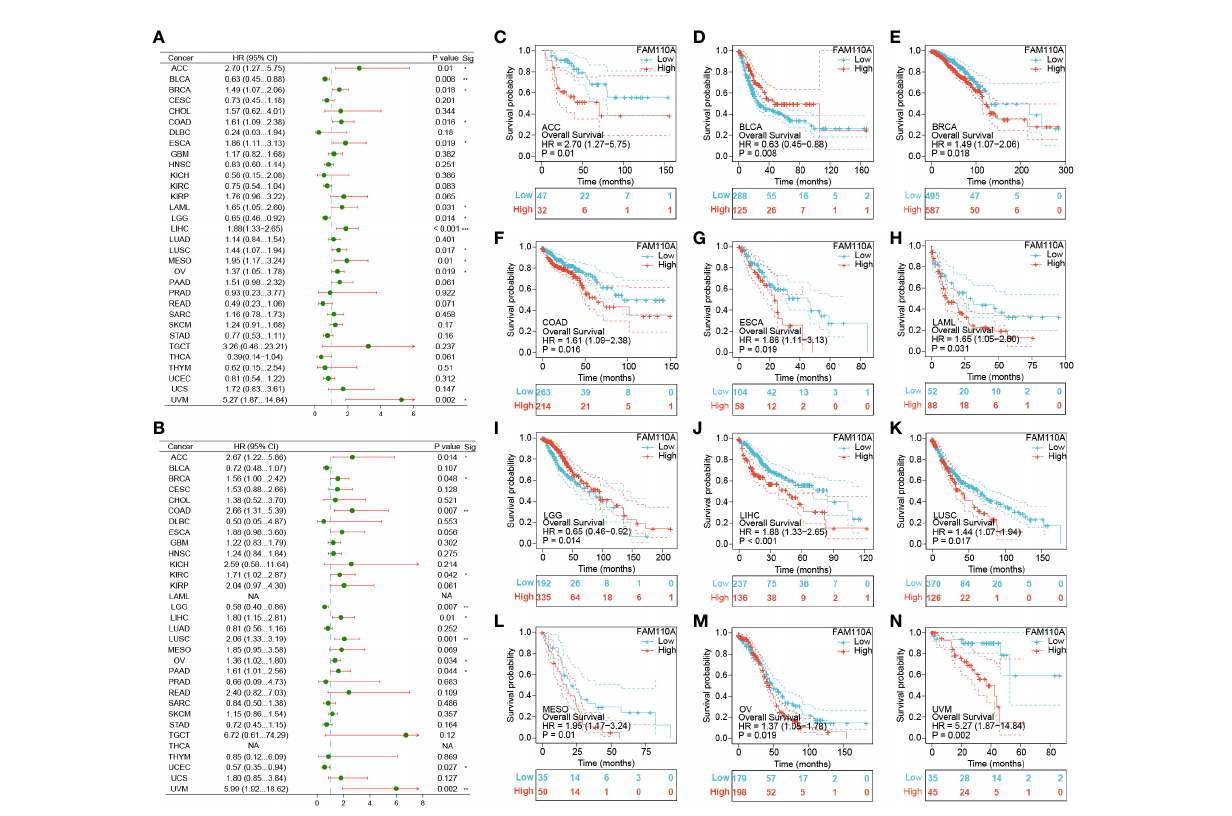
FIGURE 4 Survival analysis of FAM110A in different types of cancer in the TCGA database. (A, B) Correlation of FAM110 expression with OS and DSS in patients with different cancers (*P<0.05, **P<0.01, ***P<0.001). (C-N) Kaplan – Meier (KM) curves of OS with signi fi cance in 12 cancer types (ACC, BLCA, BRCA, COAD, ESCA, KIRC, LAML, LIHC, LUSC, MESO, OV and UVM) in